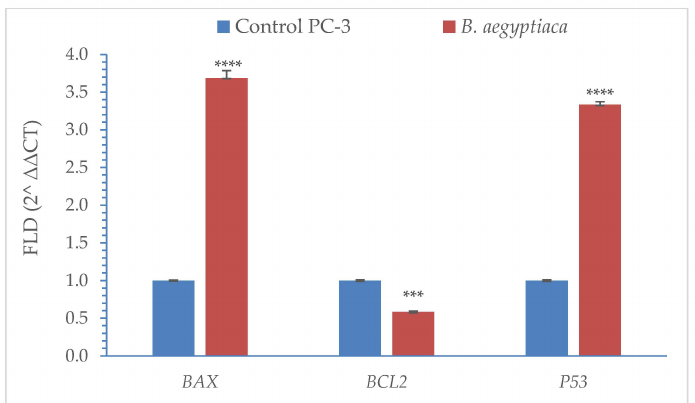
Figure 9. The qRT-PCR results for the expression of apoptosis-related genes in PC-3 cells treated with the B. aegyptiaca methanolic fruit extract at 92 µ g/mL. Statistical differences are indicated by *** at p < 0.001 and **** at p < 0.0001 assessed by independent t-test. The data were generated from 3 replicates and presented as means ± SD denoted by the vertical